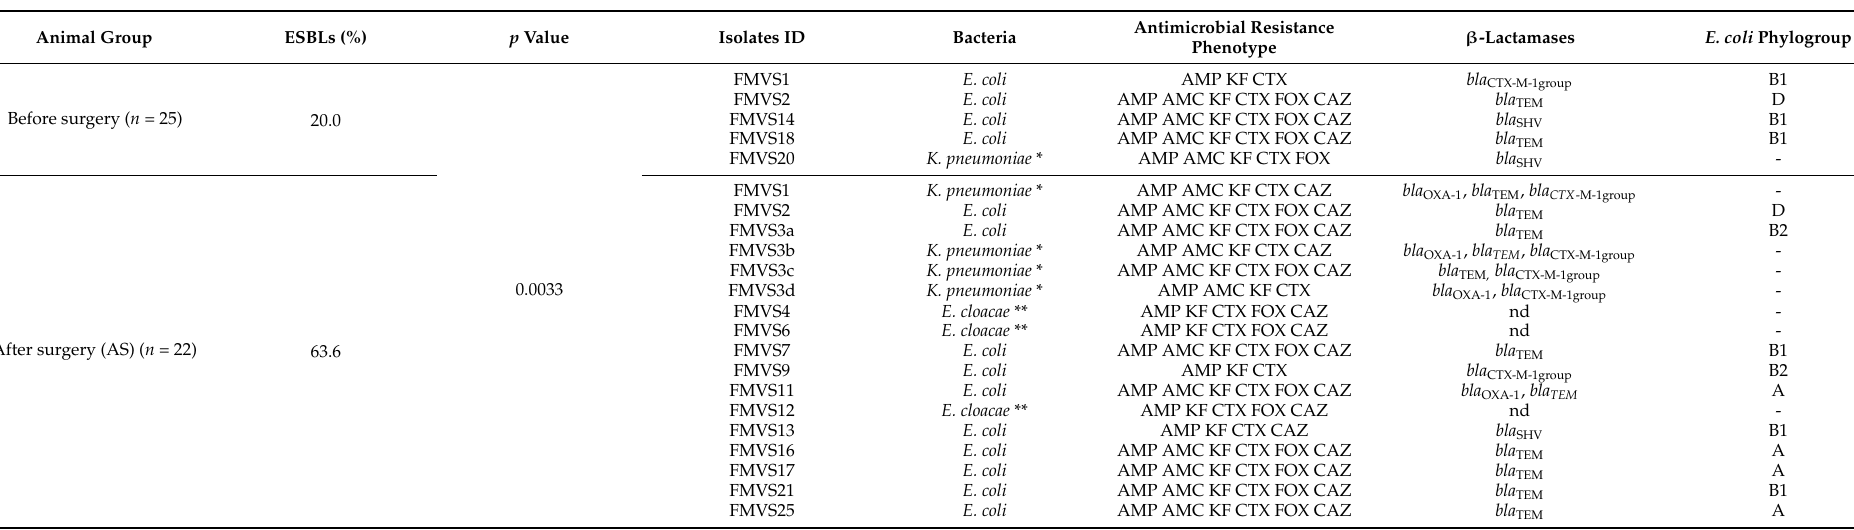
Table 2. Genotypic and phenotypic traits of ESBL/AmpC-producing Enterobacteriaceae from healthy dogs before surgery and after surgery (AS). Animal Group